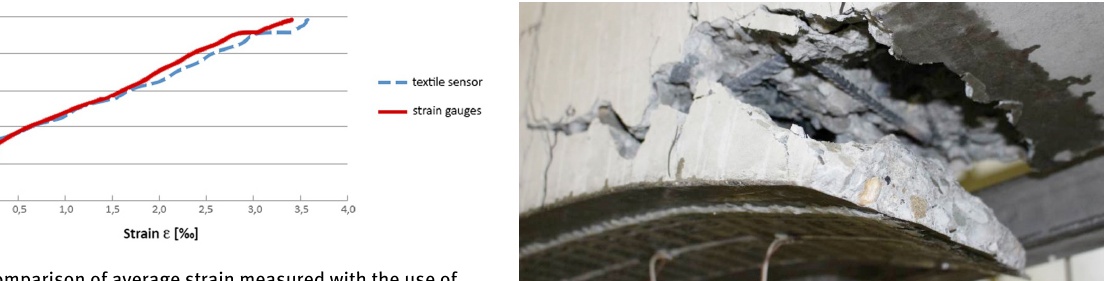
Figure 9: Tests on timber beam strengthened with textile